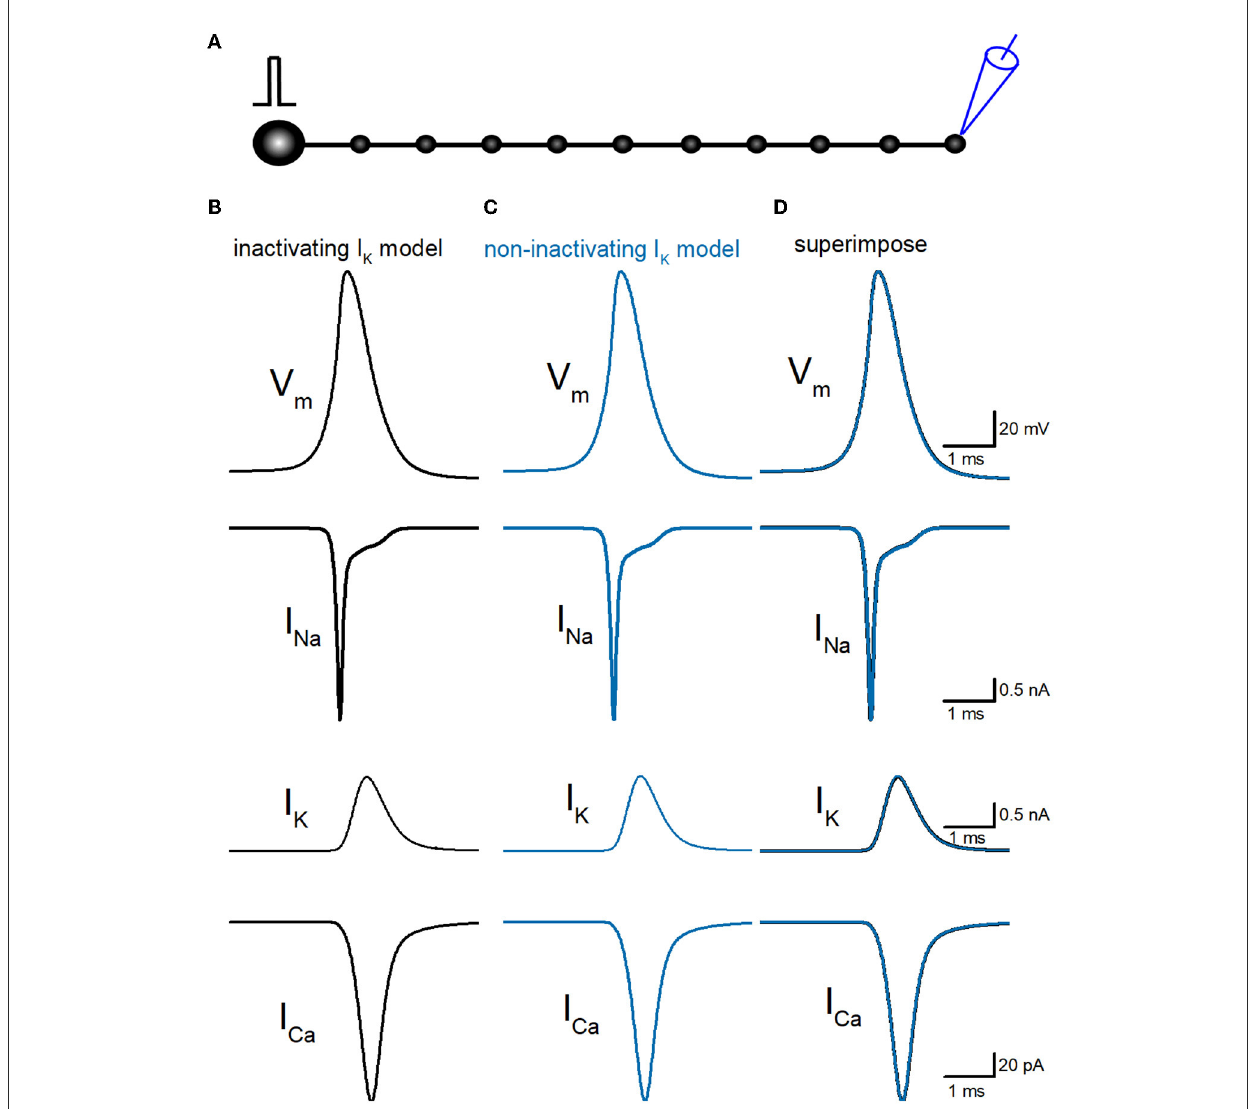
FIGURE2 Reconstruction of propagating action potentials with inactivating and non-inactivating axonal K + channels. (A) Schematic drawing of the multi-compartment model of the granule cell and mossy fiber was reconstructed according to the previous study by Alle and Geiger (2006). (B) Simulated propagating action potentials at the mossy fiber bouton (V m ), axonal Na + (I Na ), K + (I K ), and Ca 2 + (I Ca ) currents during the action potentials with the inactivating I K model. (C) Those of non-inactivating I K model (blue traces). (D) Superimposed traces of (B, C)